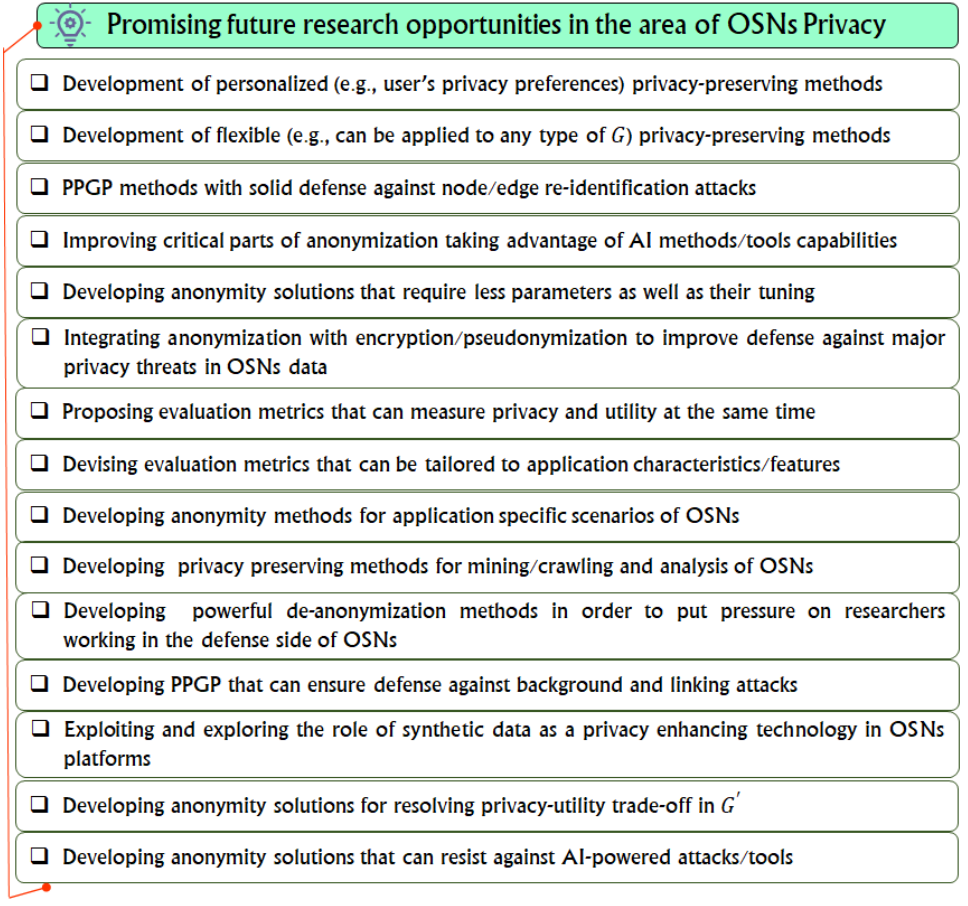
Figure 26. List of promising opportunities for future research in the area of OSN privacy